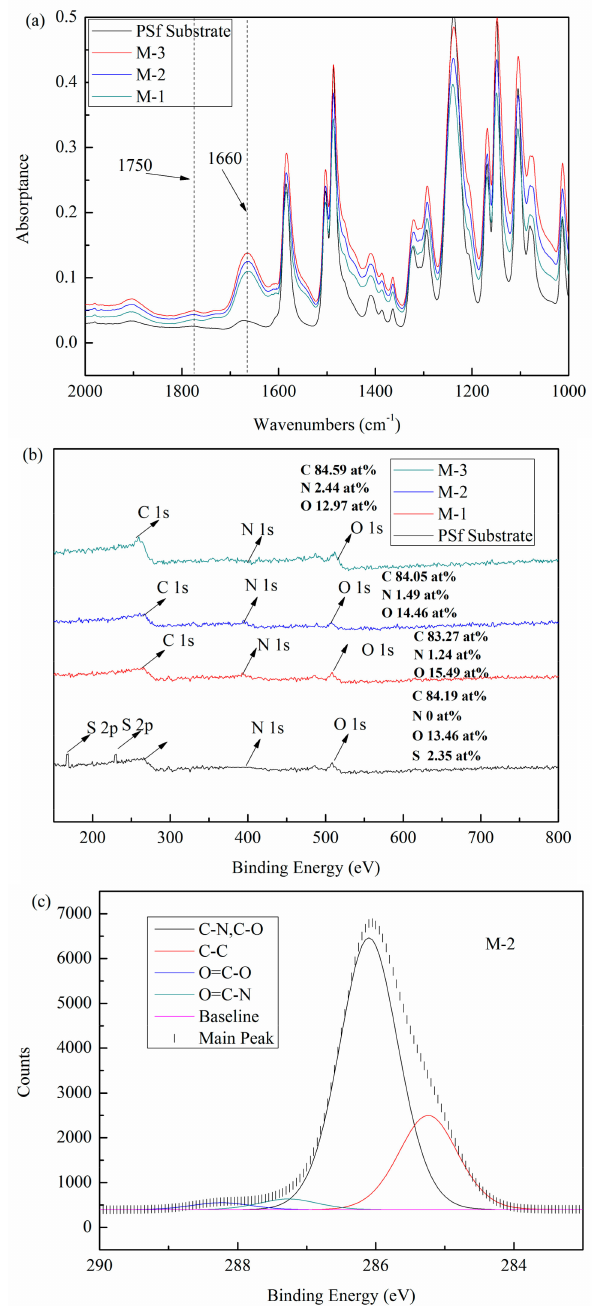
Figure 1. ( a ) Attenuated Total Reflection-Fourier Transform Infra-Red (ATR-FTIR) spectra of PSf substrate, M-1, M-2 and M-3; ( b ) X-ray photoelectron spectroscopy (XPS) spectra of the M-1, M-2 and M-3 membrane surface and ( c ) High-Resolution XPS spectrum C 1s spectra of M-2